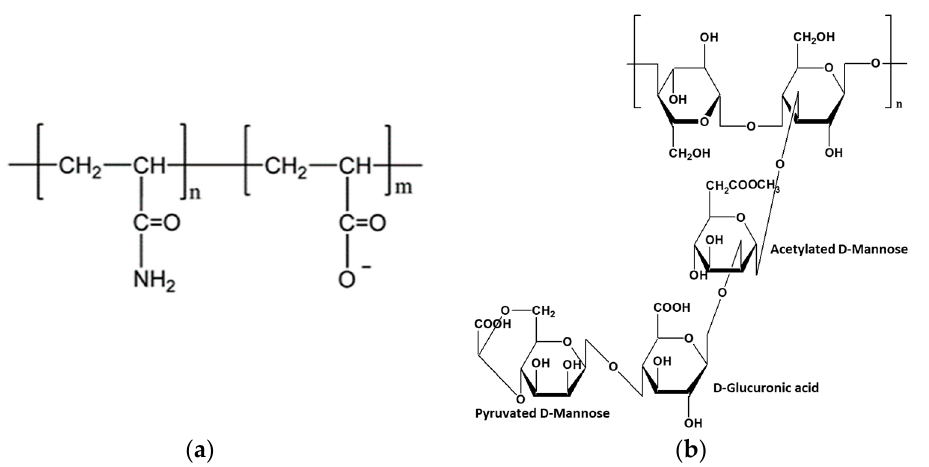
Figure 1. Molecular structure of ( a ) HPAM and ( b ) xanthan gum.